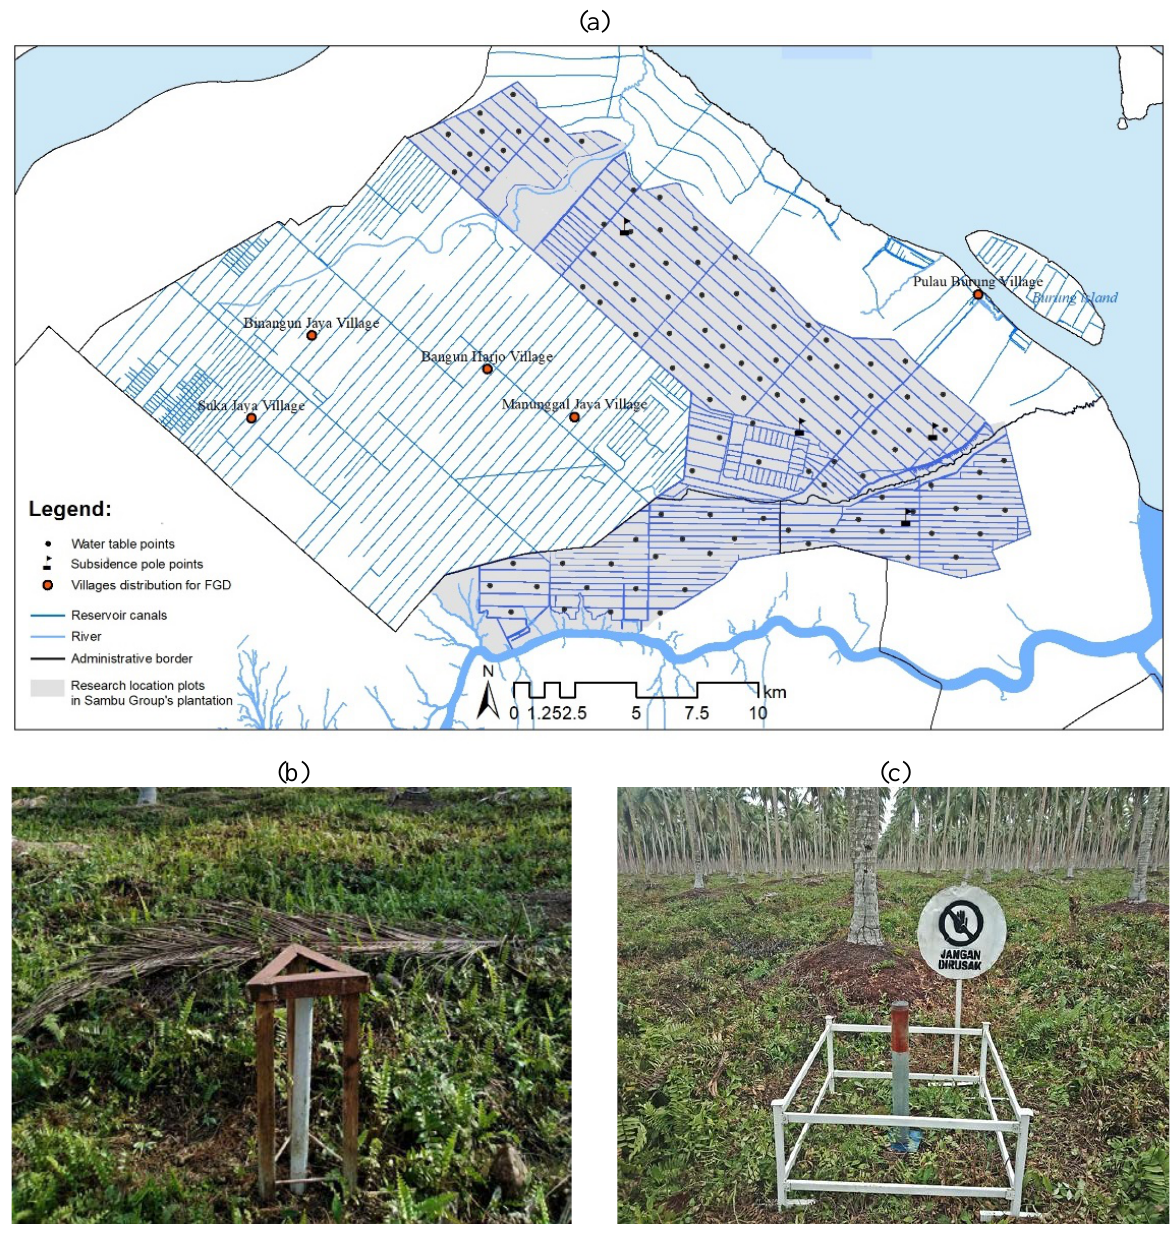
Figure 3. (a) Map showing the distribution of water table and subsidence measurement points in the Sambu Group plantation, and the locations of the five FGD villages. (b) PVC tube for measurement of water table level. (c) Iron pole for subsidence